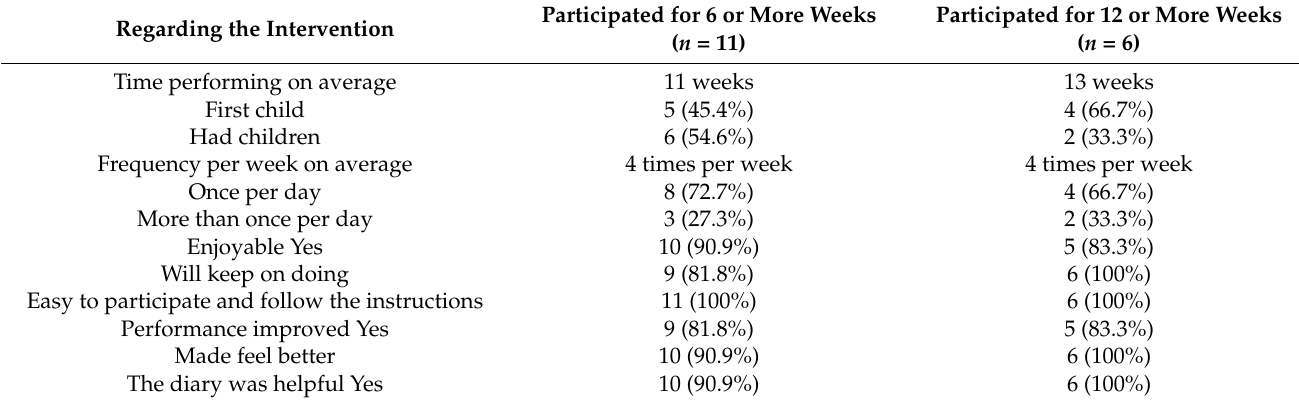
Table 1. OPALS feasibility questionnaire main results among participants completing six or more weeks of intervention. Regarding the Intervention